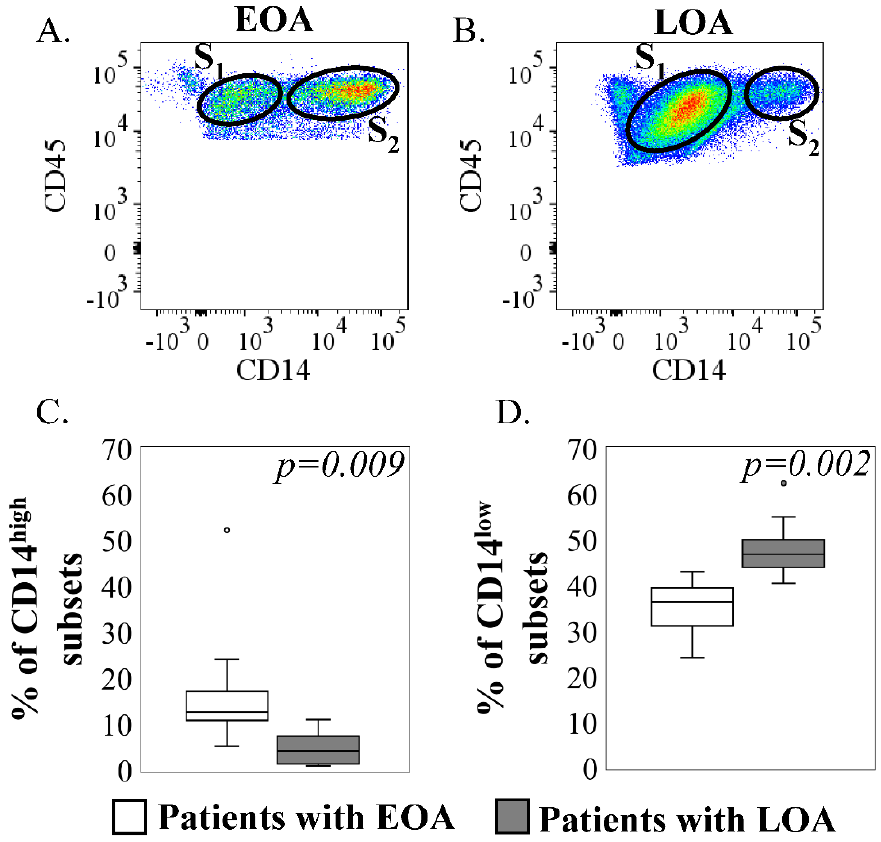
Figure 3. Differences in the proportion of CD14+ cell subsets in synovium from patients with early hip osteoarthritis (EOA) and late hip osteoarthritis (LOA) using flow cytometric analysis. Dot−plot analysis of CD14+ cells among synovial cells after CD45 gating in patients with EOA ( A ) and LOA ( B ). X axis, CD14; Y axis, CD45. S 1 and S 2 represent the CD14 low and CD14 high cell subsets, respectively. ( C ) The comparison of percentage of CD14 high subsets in CD45+ cells between EOA (white) and LOA (gray). ( D ) The comparison of percentages of CD14 low subsets in CD45+ cells between EOA (white) and LOA (gray). 3C represents the percentage of CD14 high , and 3D represents the percentage of CD14 low cells of patients with EOA (white) and LOA (gray). Boxes represent median and IQR (interquartile range, 25−75th percentiles); small circle represent values outside 1.5 × IQR. Mann– Whitney U -test was used for analysis. p < 0.05 indicates statistical significance.